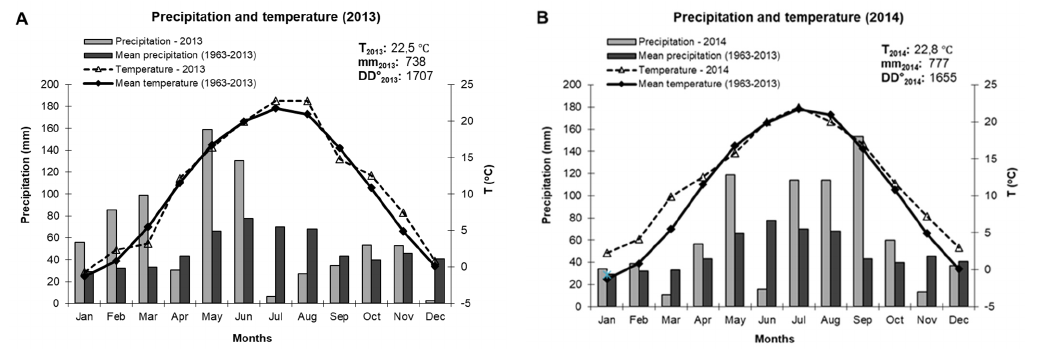
Figure 2. ( A , B ) Average air temperature (lines) and the monthly sum of precipitation (columns) in 2013 ( A ) and 2014 ( B ) compared to the data of the last 50 years. The characteristics of the vintage